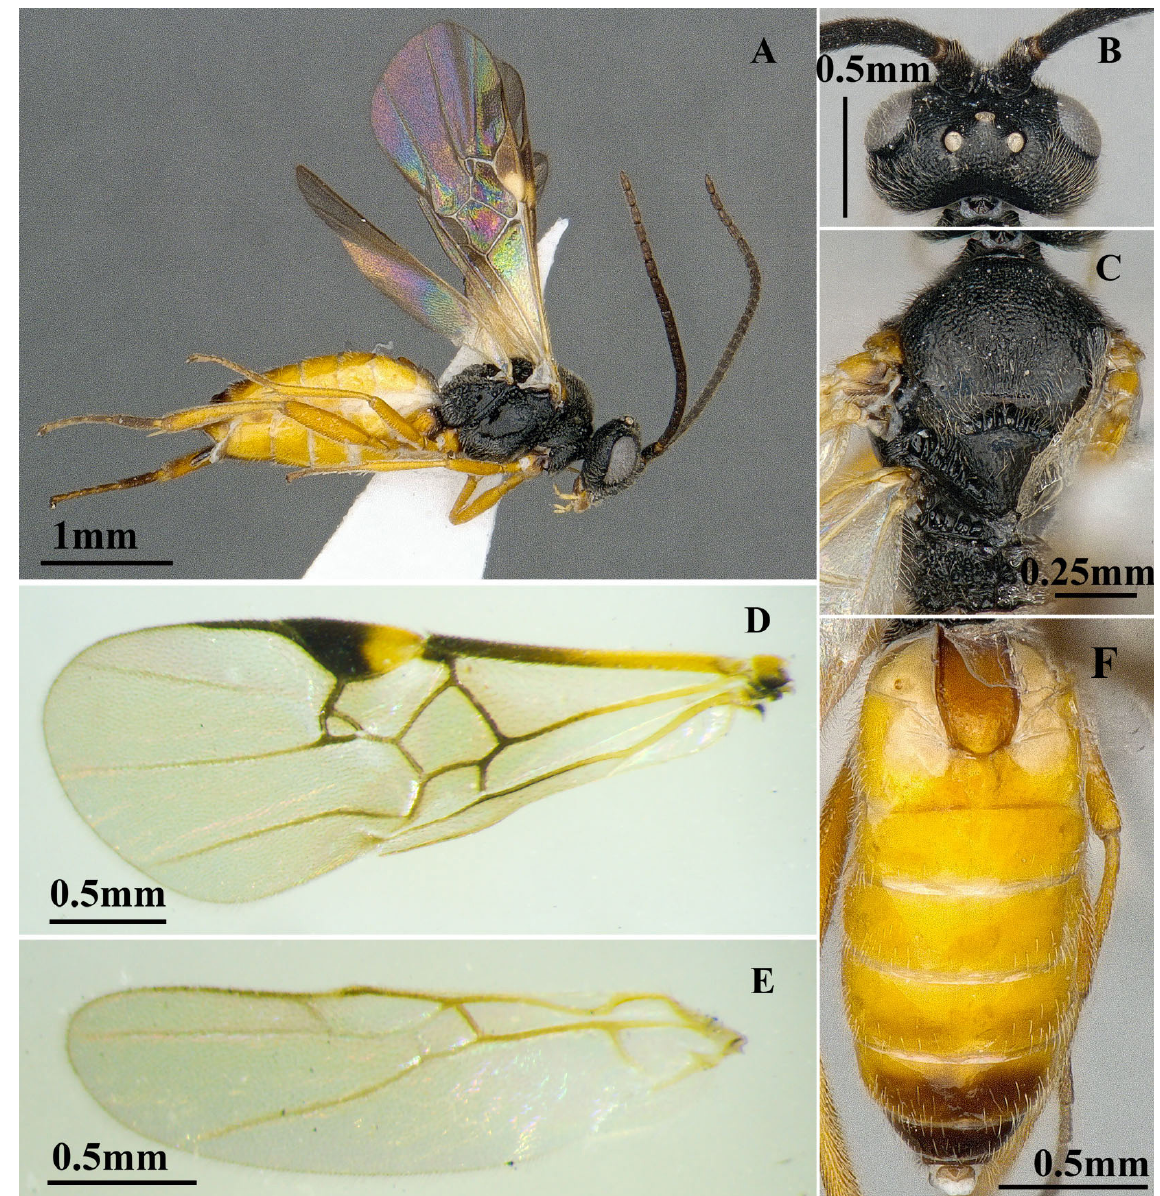
Fig. 10. Microplitis rufiventris Kokujev, 1914, ♀, TMUC-HBMMP0057. A . Habitus, lateral view. B . Head, dorsal view. C . Mesosoma, dorsal view. D . Fore wing. E . Hind wing. F . Metasoma, dorsal